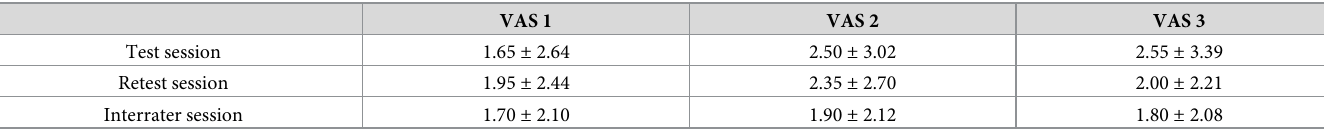
Table 5. Visual analog scale scores for pain before, between and after